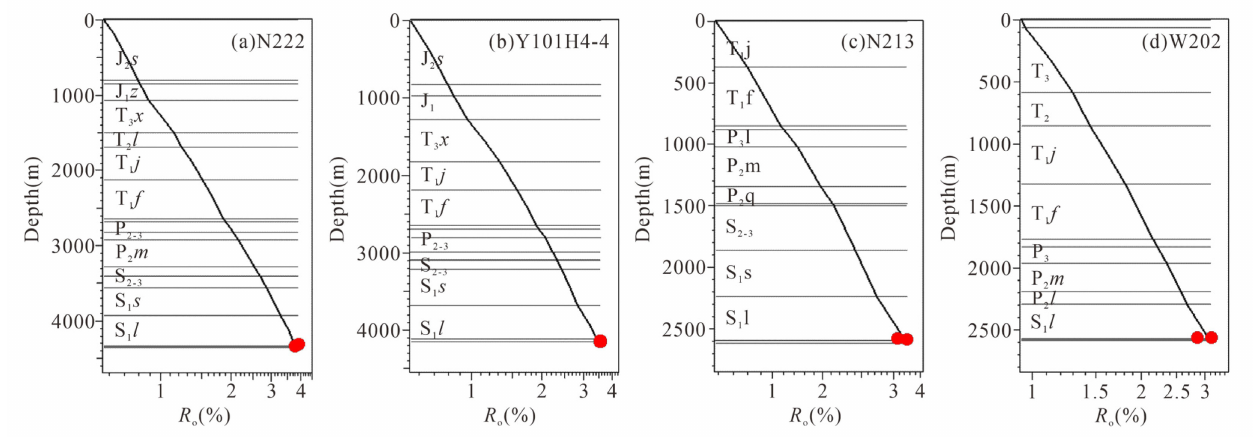
Figure 11. R o simulation value (curves) versus calculated EqVR o (red dots) for well N222 ( a ), Y101H4-4 ( b ), N213 ( c ) and W202 ( d